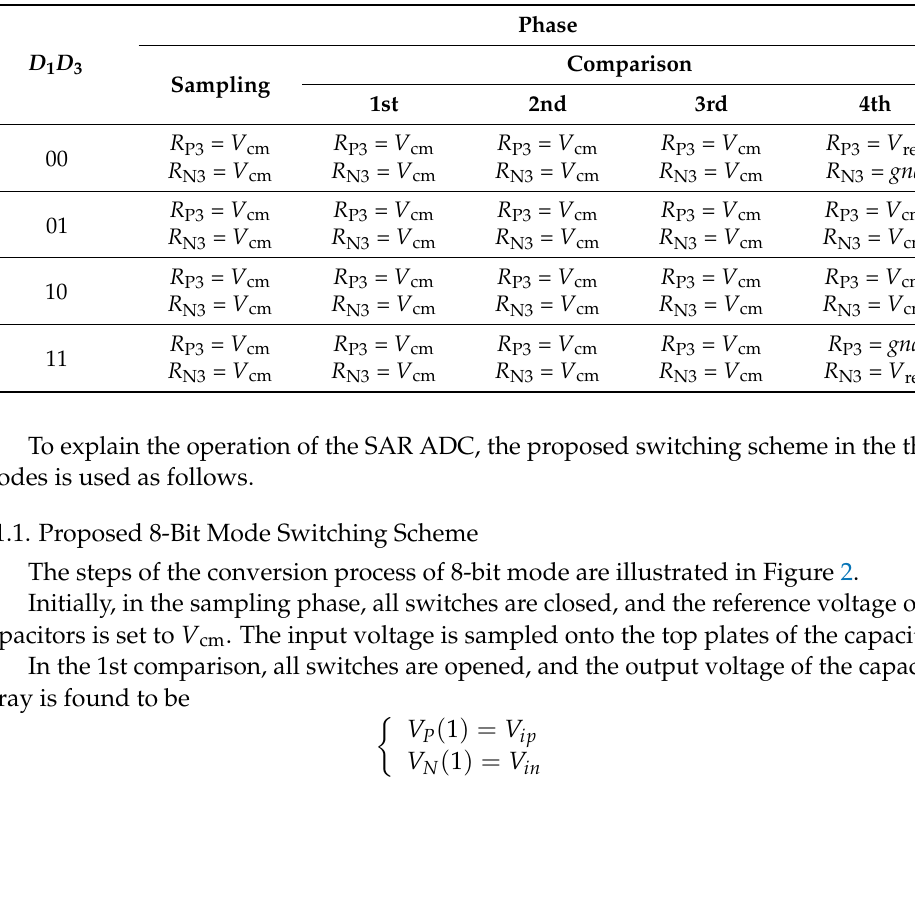
Table 4. R P3 and R N3 for each phase of 10-bit